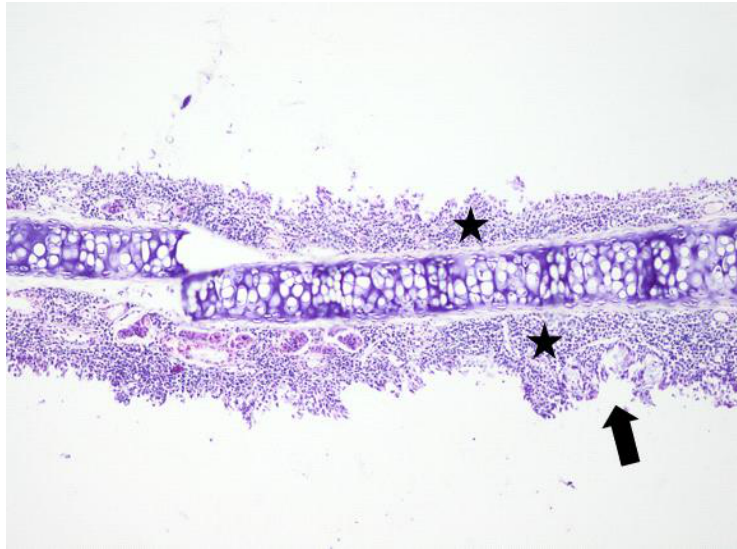
Figure 6. Light micrographs of the rat’s nasal septum, astaxanthin group, at 14 days after the intranasal intervention. Diffusely, the lamina propria of the mucosa covering the nasal septum is markedly expanded by many macrophages admixed with lymphocytes and few plasma cells (black star). The covering mucosa is focally erosive and occasionally hyperplastic (arrow); H&E, ob ×10. On day 28 in the control group, the epithelium shows areas of mucous hyperplasia, perilesional seromucous glands and goblet cell hyperplasia. There is moderate subepithelial fibrosis